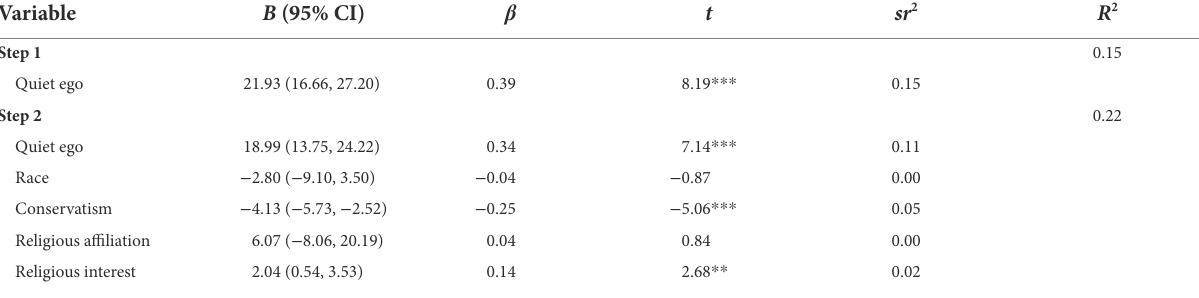
TABLE 2 Regression results for Study